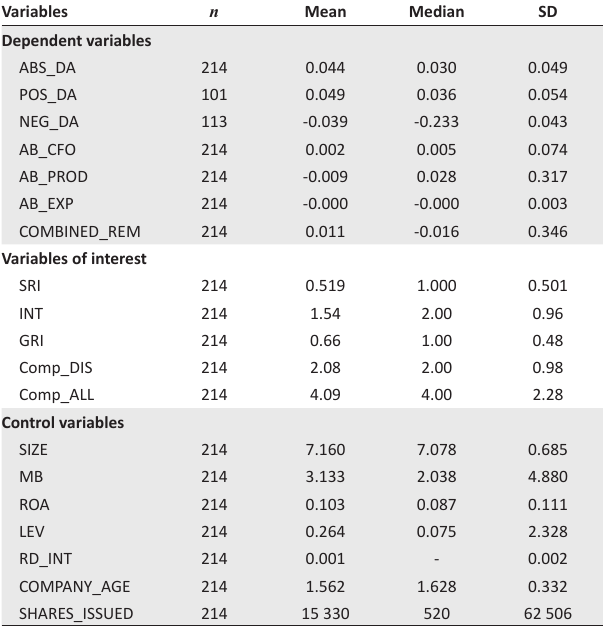
TABLE 2: Descriptive statistics on selected variables. Variables